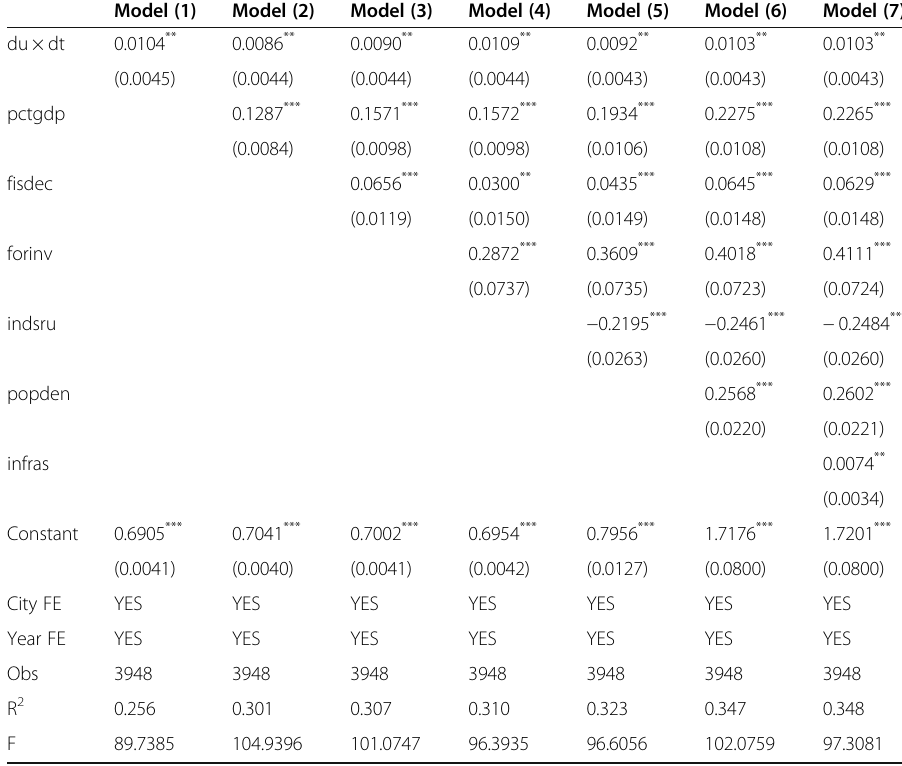
Table 3 Results of the benchmark